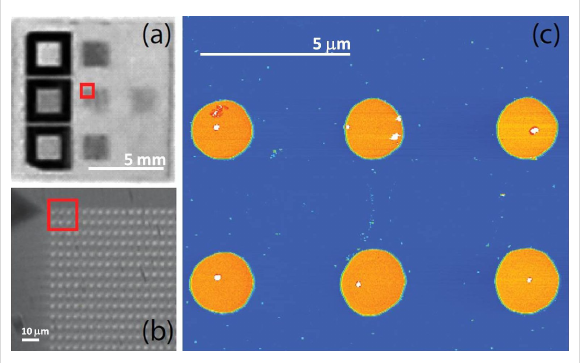
Figure 1: (a) An optical image of nine different reference grids on a 10 × 10 mm 2 sapphire substrate; (b) Optical zoom showing the grid struc- ture comprising gold pillars 2 μ m in diameter, 75 nm tall, with a centre- to-centre distance of 5 μ m; (c) AFM image of a number of the grid cells. Quantum dots (QDs) are visible as small dots in the